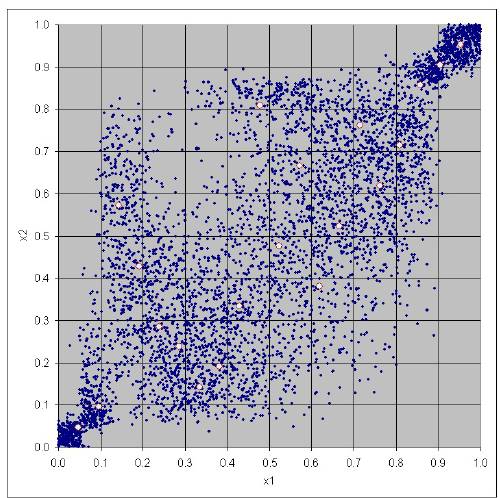
Figure 17. Empirical copula, m =